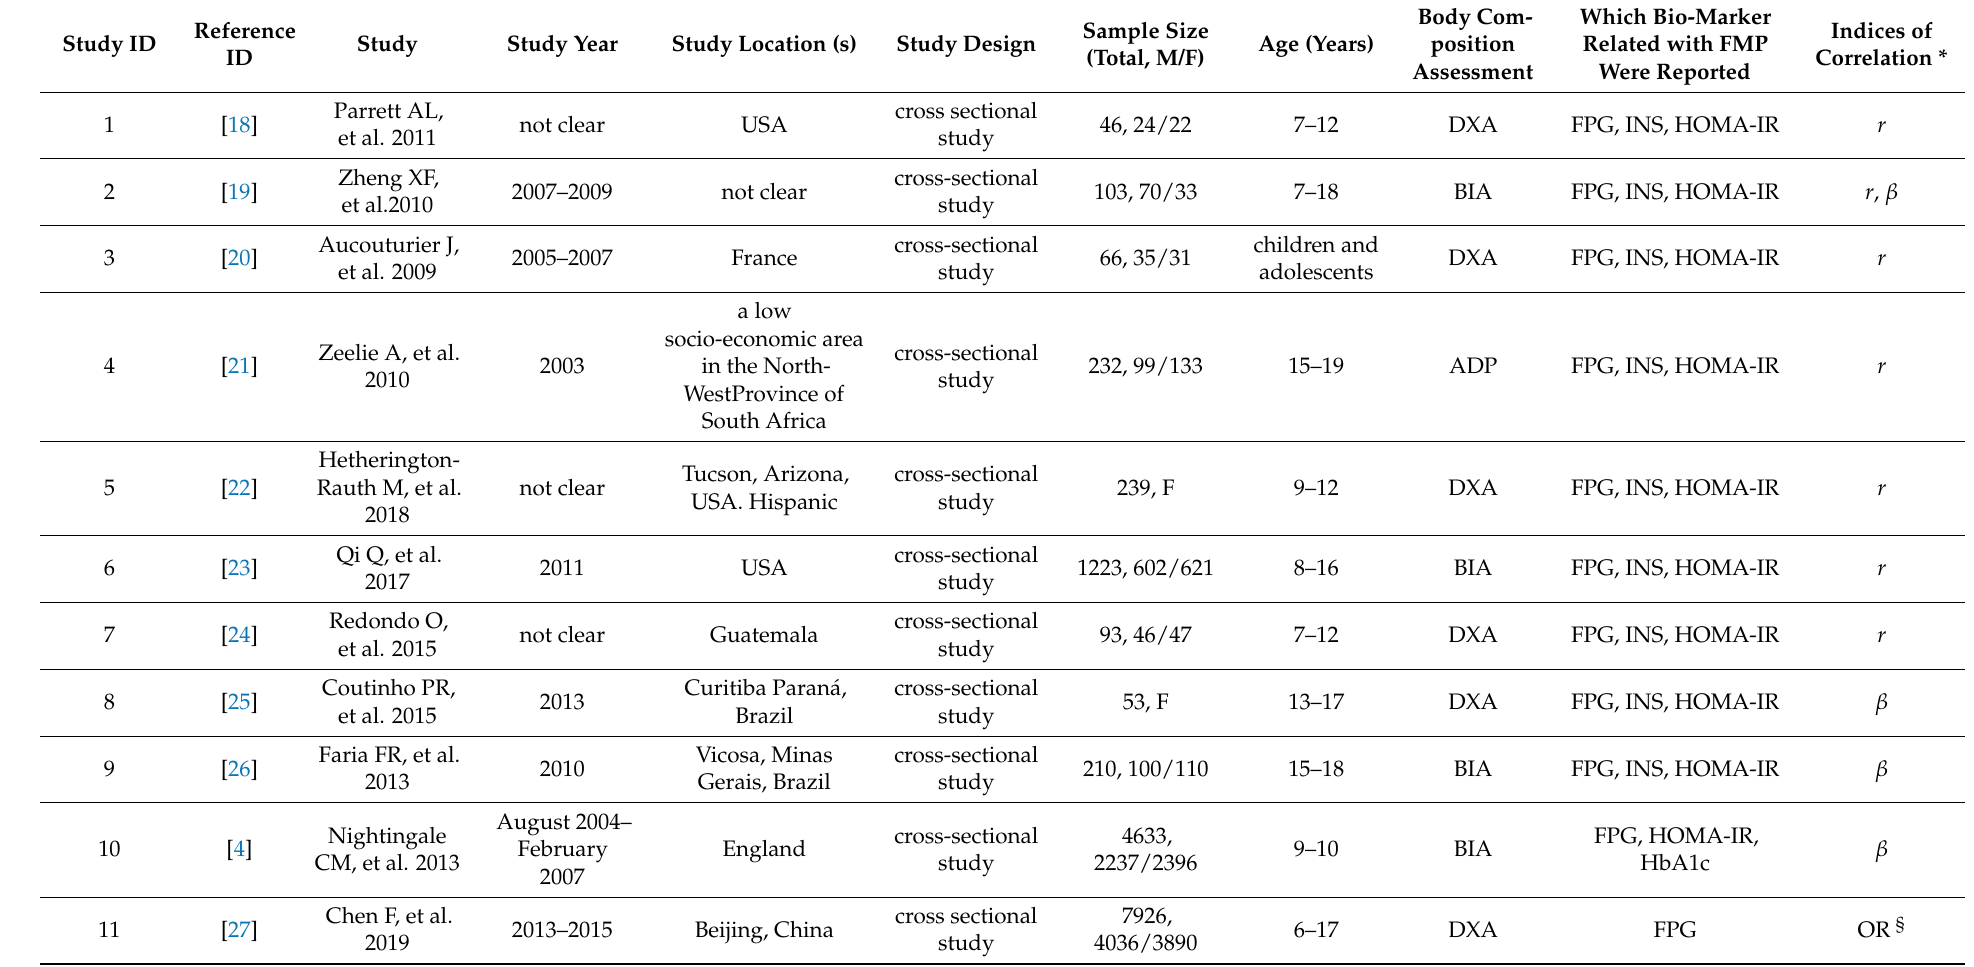
Table 1. Characteristics of the included